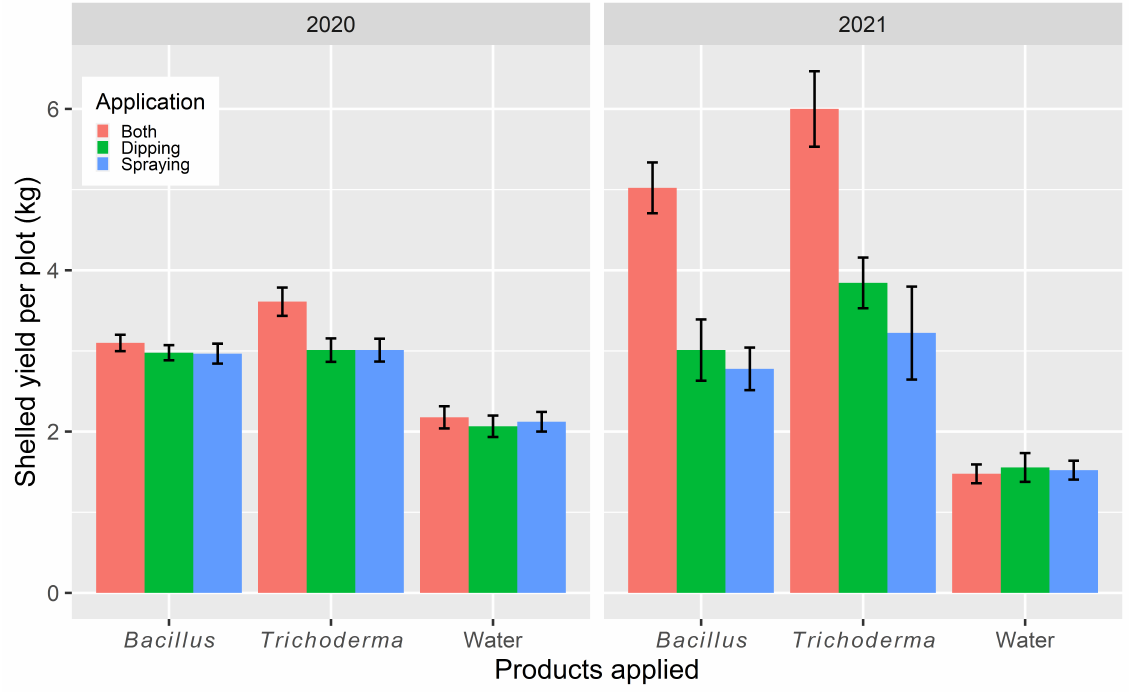
Figure 8. Net grain yield (kg) per plot (size 5 × 5 m) of rice plants that had received water or one of the two biopesticides at different times (dipping at transplanting, foliar spraying post-transplanting, or at both times) at three sites in 2020 and 2021 in Tanzania. The bar represents one standard